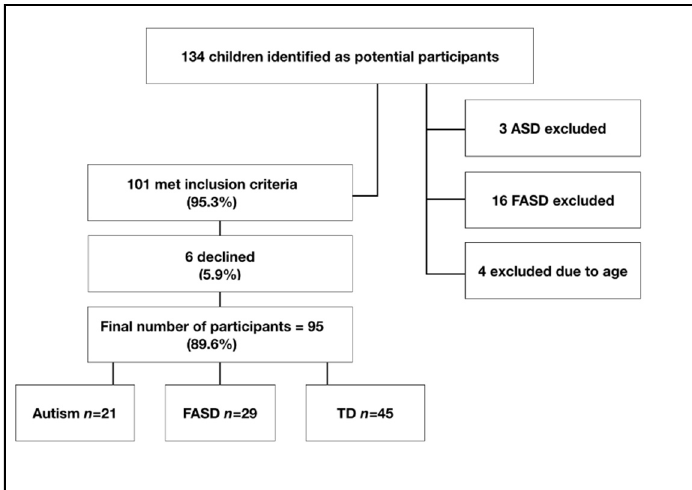
Figure 1. Flow chart detailing number of